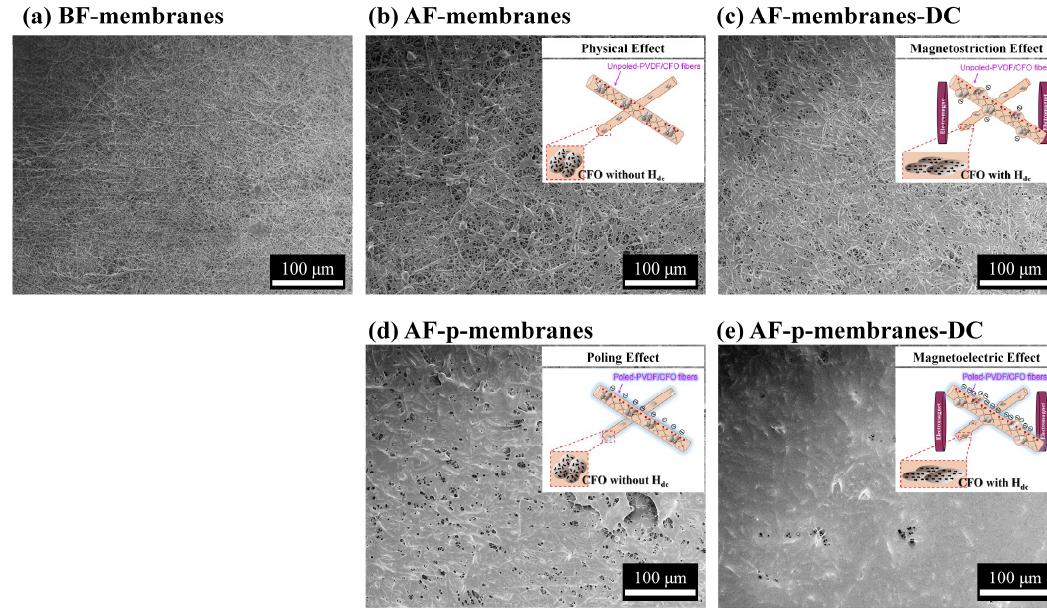
Figure 5. SEM images of ( a ) PVDF/CFO membranes before PM filtration (BF-membranes), ( b ) Figure5. SEMimagesof( a )PVDF / CFOmembranesbeforePMfiltration(BF-membranes), ( b )PVDF / CFO PVDF/CFO membranes after PM filtration under H dc = 0 Oe (AF-membranes), ( c ) PVDF/CFO membranes after PM filtration under H dc = 0 Oe (AF-membranes), ( c ) PVDF / CFO membranes after membranes after PM filtration under H dc = 700 Oe (AF-membranes-DC), ( d ) poled-PVDF/CFO PM filtration under H dc = 700 Oe (AF-membranes-DC), ( d ) poled-PVDF / CFO membranes after PM membranes after PM filtration under H dc = 0 Oe (AF-p-membranes), and ( e ) poled-PVDF/CFO filtration under H dc = 0 Oe (AF-p-membranes), and ( e ) poled-PVDF / CFO membranes after PM filtration membranes after PM filtration under H dc = 700 Oe (AF-p-membranes-DC). under H dc = 700 Oe To quantitatively compare the PM capturing efficiency of the ME membrane filters, EDS mapping was systematically conducted on the whole area of the membranes with a mapping range